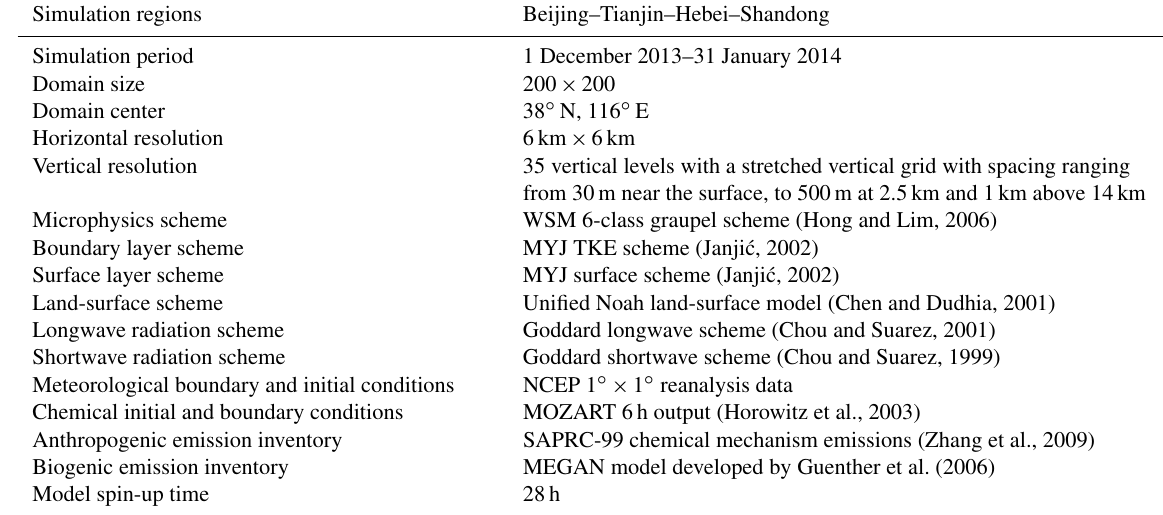
Table 1. WRF-CHEM model configurations. Simulation